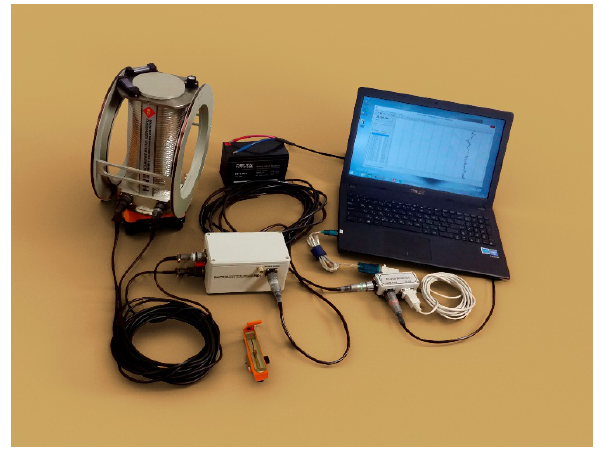
Figure 2. Field switching scheme in a vertical magnetiz- ing